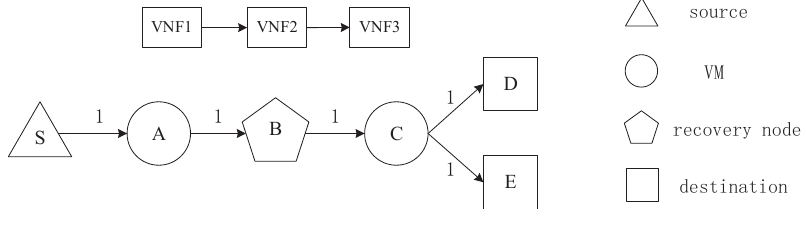
Figure 4. Reliable transmission